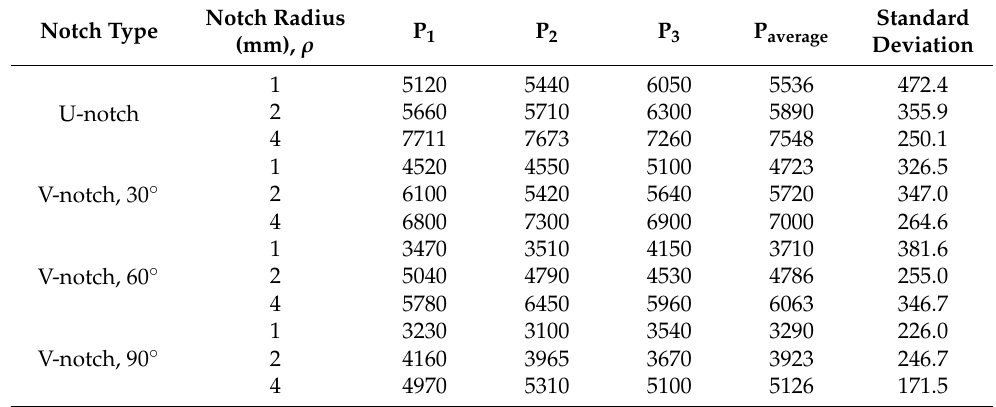
Table 3. Experimental fracture loads (N) of cross-ply composite Brazilian disks.